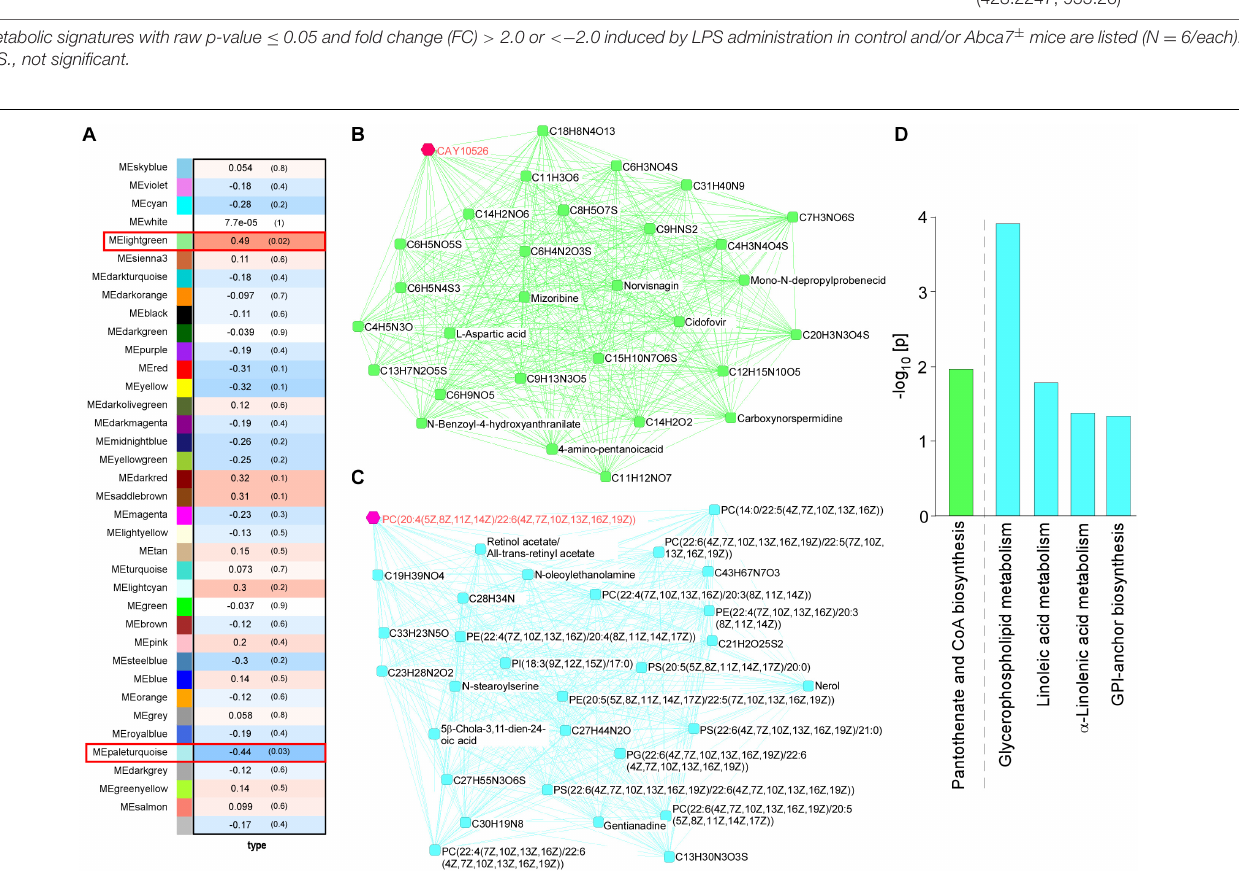
Frontiers in Neuroscience |